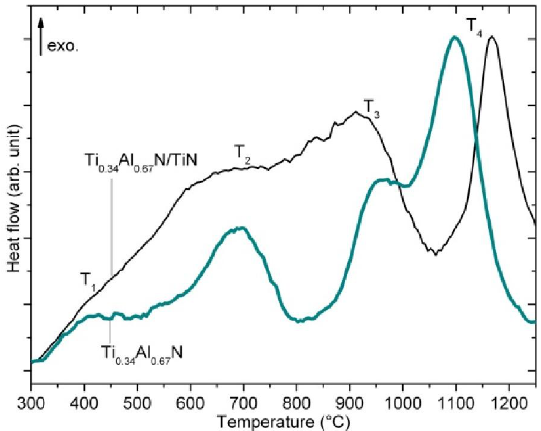
Figure 8. Differential scanning calorimetry measurements of the monolithic and multilayered coating